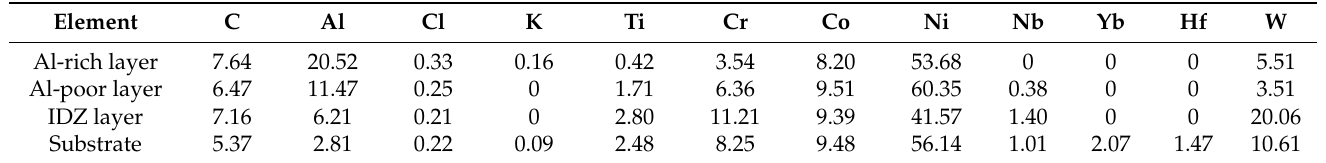
Table 2. Elemental composition of coatings and substrate